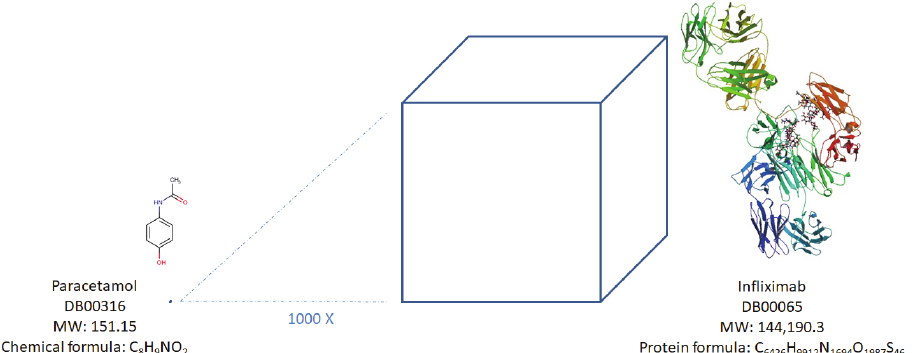
FIGURE 1 - Comparison of a synthetic drug with a biological drug. A: the structure of Paracetamol, a small molecule usually used as an analgesic and antipyretic. B: The structure of Infliximab, a monoclonal antibody (mAb) used in rheumatoid arthritis treatment among other diseases. Adapted from: